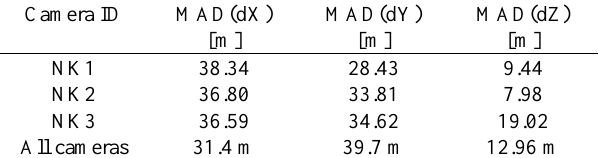
Figure 5 : Comparison between transformed SFM view point coordinates and cartographic GPS coordinates according to stand out. Table 1: Median Absolute Deviation (MAD) of misfits between GPS and SFM transformed coordinates. The MAD robust criterion contains 66% of observations.